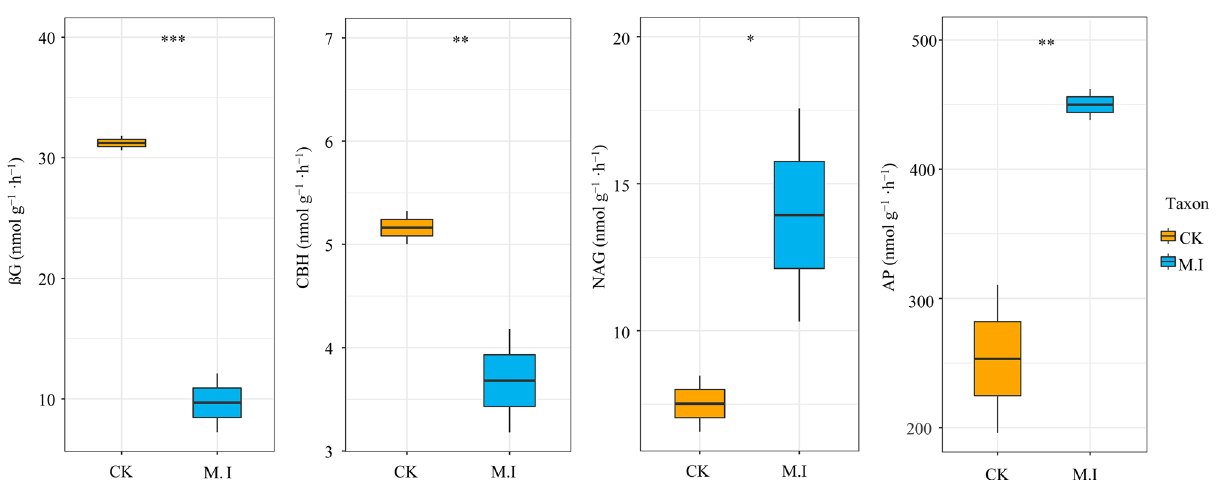
Figure 5. Enzyme activities in soil of M. micrantha invasive and non-invasive forests. βG: β-glucosidase (EC 3.2.1.21), CBH: cellobiohydrolase (EC 3.2.1.91), NAG: N-acetyl-β-D-glucosaminidase (EC 3.2.1.30), AP AP: Acid phosphatase (EC